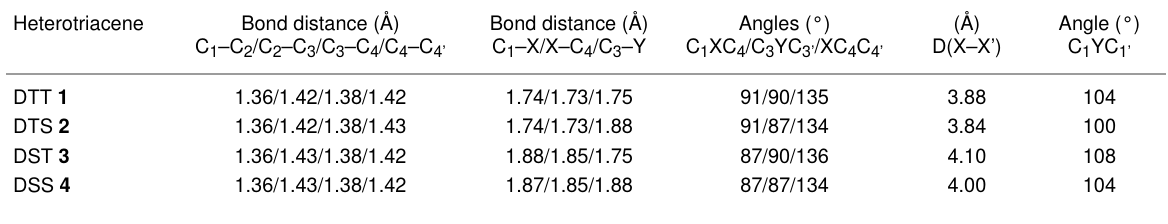
Table 2: DFT quantum chemical calculations on the geometry of heterotriacenes 1–4 . Heterotriacene